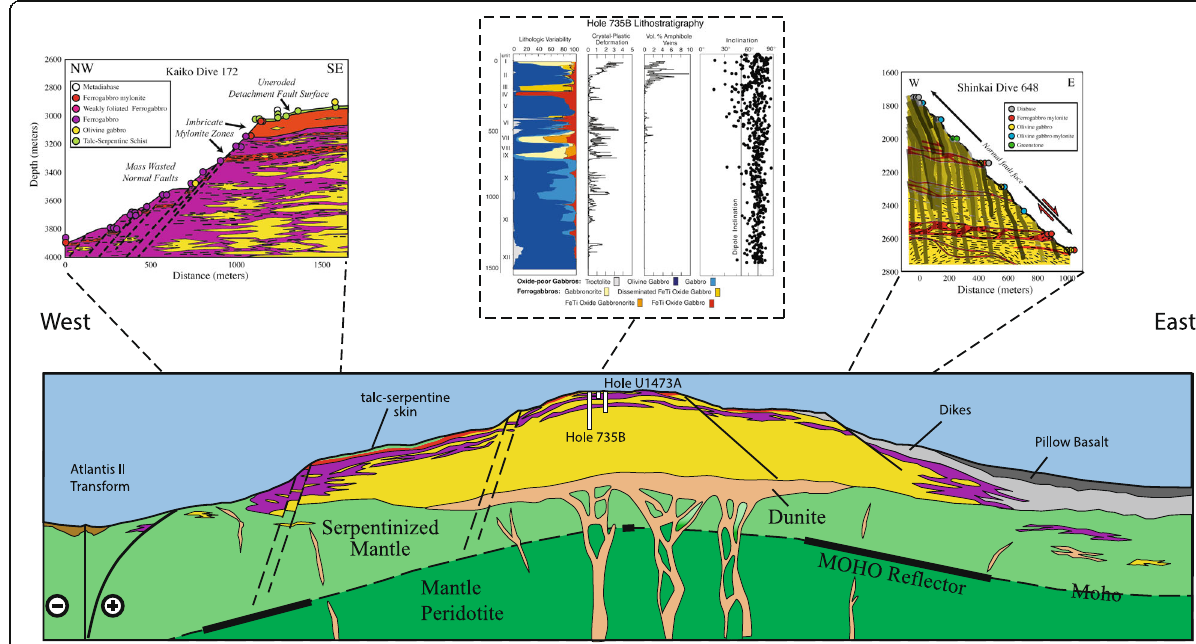
Fig. 50 East-west cross-section of Atlantis Bank through Hole 735B based on the seafloor geology and ODP and IODP drill cores. Subsurface geology at depth including dunite melt transport zone and basal cumulates, and the location of crust-mantle boundary is somewhat arbitrary as the seismic data are not definitive, and we only know that a considerable volume of primitive cumulates must lie below the hole. Heavy black lines show the Moho reflectors (Minshull et al. 1998; Muller et al. 2000; Muller et al. 1997). The gaps are attributed to the geometry of ocean bottom seismometer emplacement and ray tracing. Best guess model for Moho and crust-mantle boundary are shown — but only drilling will tell. Lithologic units in the gabbro massif are identified by color in the inset dive